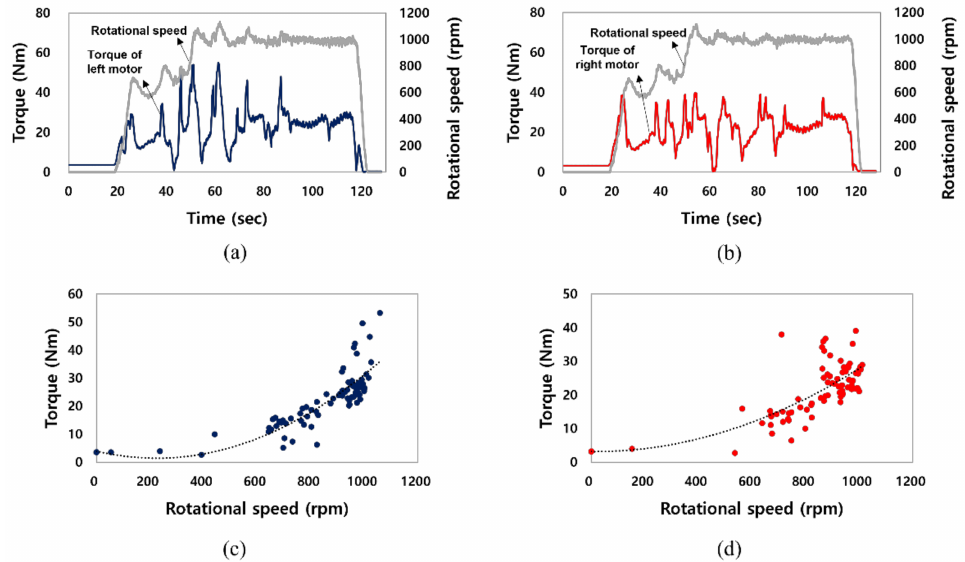
Figure 5. Results of the electric motor torque and rotational speed tests: ( a ) torque and rotational speed of the left (front) motor as time, ( b ) torque and rotational speed of the right (rear) motor as time, ( c ) torque of the left (front) motor as rotational speed, and ( d ) torque of the right (rear) motor as rotational speed.